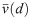
Mean race velocity v¯(d) as function of race distance.Velocity is re-scaled by vm, and distance d is re-scaled by dc = vmtc. Shown are the male and female world records (WR, dots), model prediction from Eq (12) (solid lines), and a typically expected maximal range of velocities (gray regions). Indicated are the lower and upper limits of γs and γl for these regions. Due to the re-scaling of v¯(d) and d, this graph highlights endurance for short and long duration, independently of the velocity vm at maximal aerobic power.